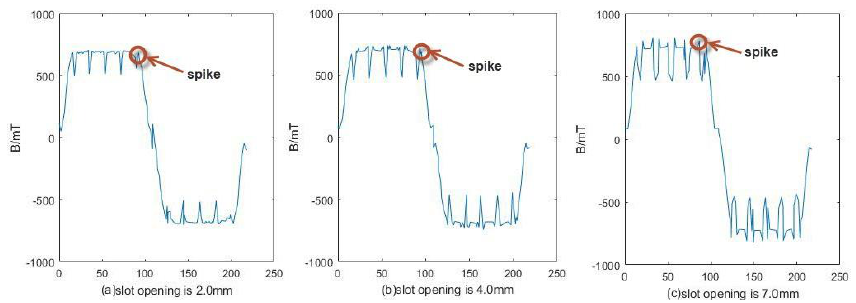
Figure 2. Air gap flux density of two poles when the slot openings are